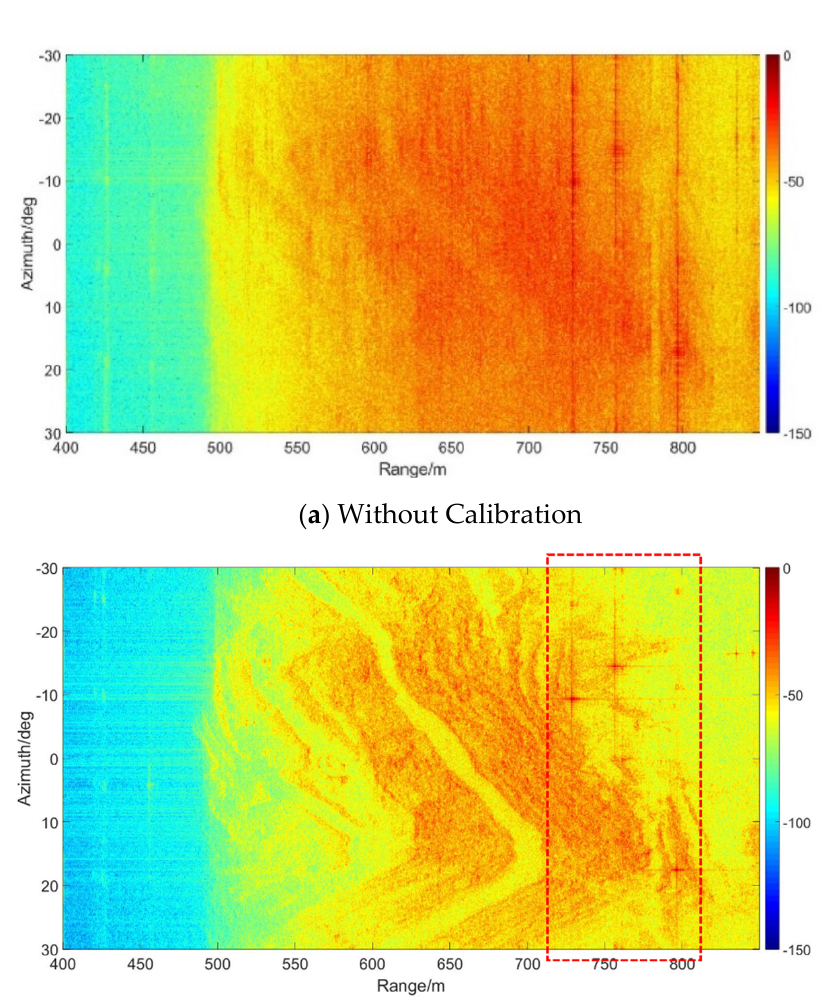
Figure 10. The scene of the experiment.